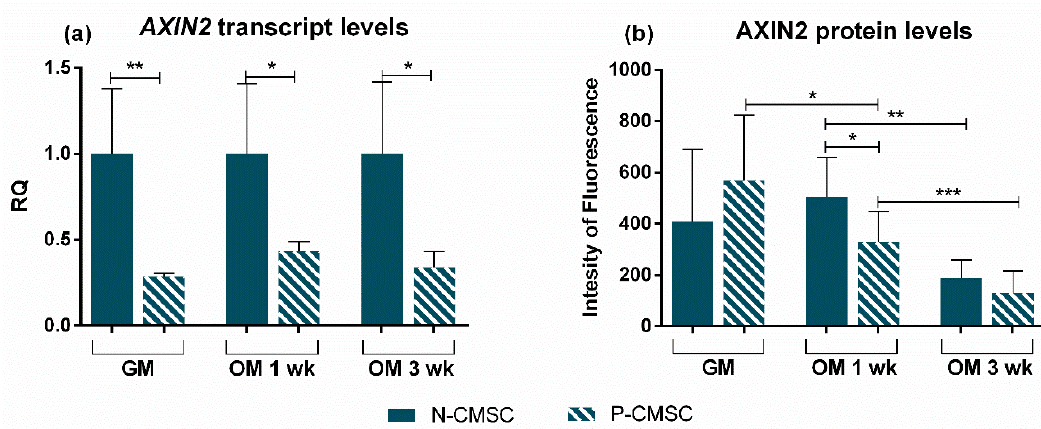
Figure 9. Comparative expression profiling of AXIN2 gene and protein in N-versus-P-CMSC. ( a ) Transcript and ( b ) protein levels of AXIN2 compared in P-CMSC versus N-CMSC, in standard growth conditions (GM) and following one (1 wk) and three weeks (3 wk) of osteogenic commitment (OM). RQ, Relative Quantity (see Methods for details). * p < 0.05; ** p < 0.01; *** p < 0.001.